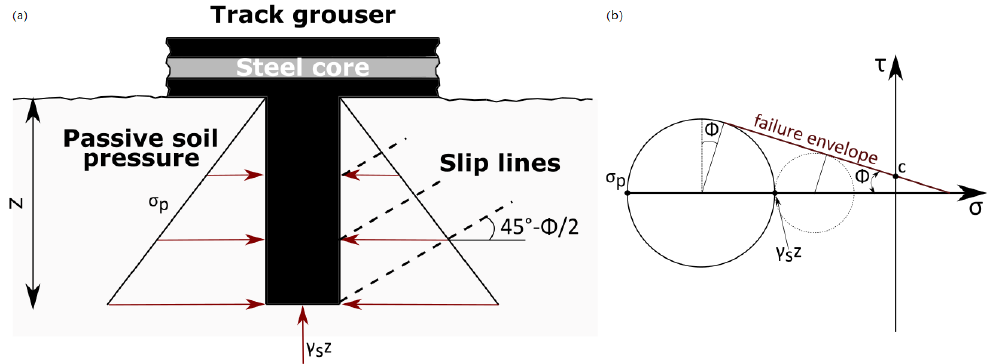
Figure 2. ( a ) Soil prism under passive compression; ( b ) Mohr circle.